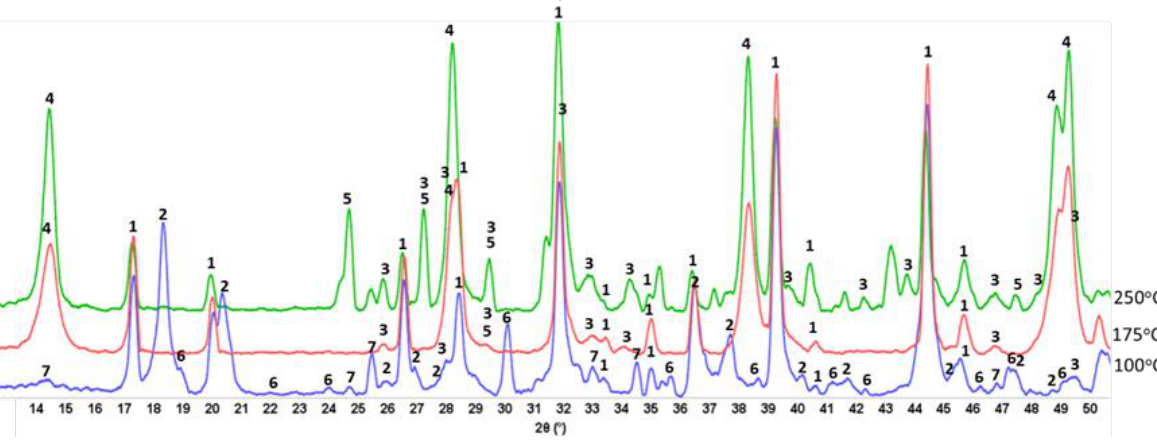
Figure 5. Diffractograms for 100-, 175-, and 250 °C-autoclaved neat CaP cements: 1-katoite (ICDD#00-024-0217/01-077-0240/01-084-01354/01-074-9779); 2-gibbsite (01-076-1782); 3-hydroxyapatite (04-016-1647/04-011-6221/01-074-9779); 4-boehmite (04-010-5683); 5-calcium carbonate (01-085-6719); 6-krotite (00-023-1037); and 7-grossite (00-023-1037).